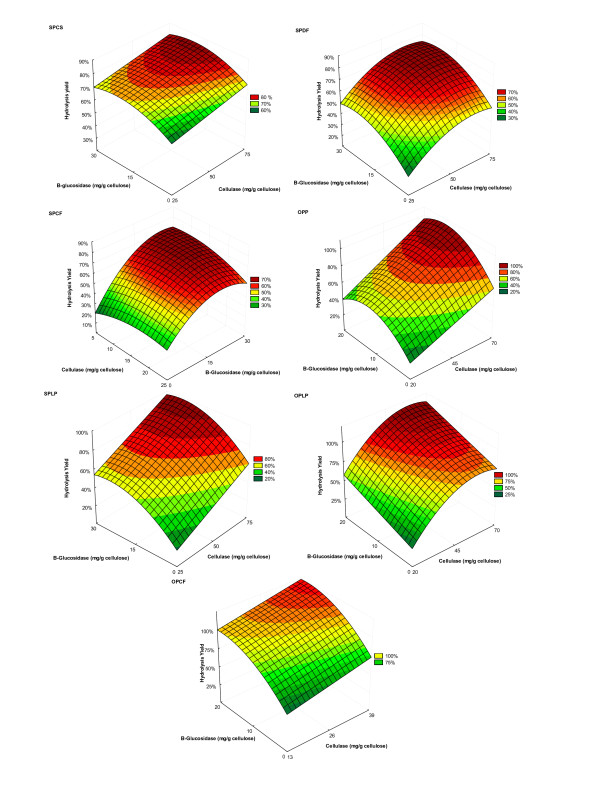
Response surface fitted to the experimental data corresponding to the hydrolysis of a broad range of pretreated substrates. Hydrolysis times and solids loadings were kept constant at 72 hours and 2% (w/v), respectively.